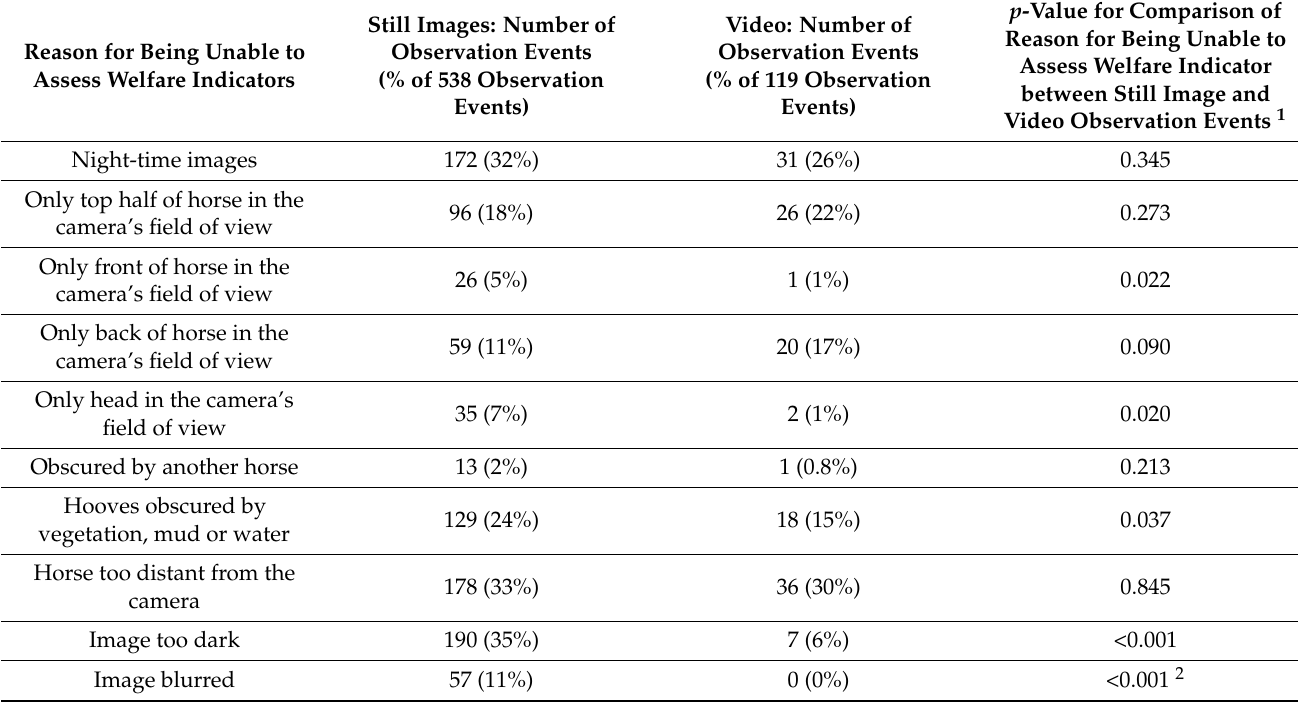
Table 8. Reasons for being unable to assess welfare indicators on camera trap still images and